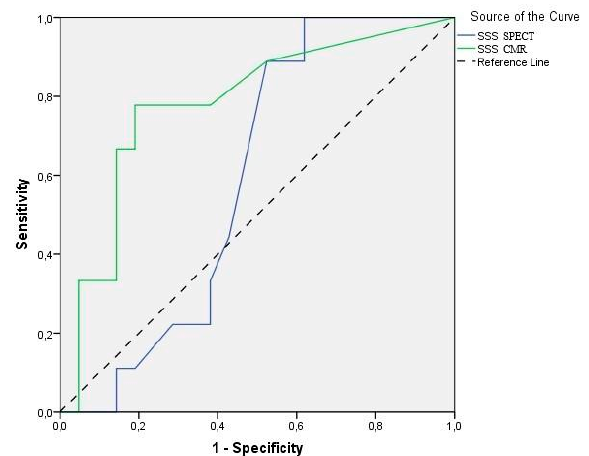
Figure 2. Receiver-operating characteristic (ROC) curves of summed stress score (SSS) for stress CMR and SPECT myocardial perfusion imaging (MPI) in detecting significant angiographic CAD ( ≥ 70% stenosis). The area under curve (AUC) was 0.78 and 0.59 for CMR and SPECT, respectively. Only CMR detected CAD had the ability to predict positive findings on coronary angiography ( p < 0.01).